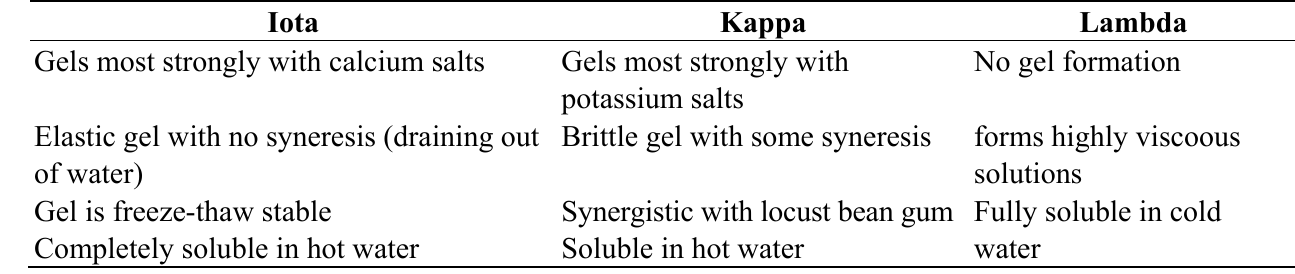
Table 5. Types of